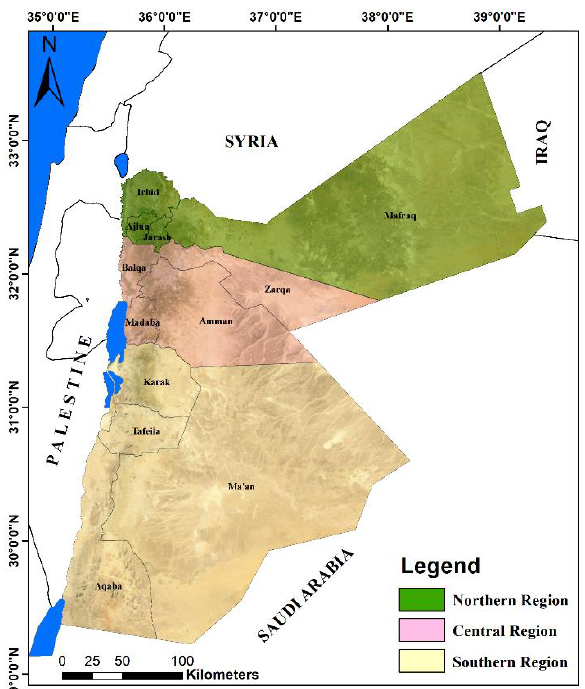
Figure 1. The Hashemite Kingdom of Jordan, Source: GIS World Imagery, GeoEye IKONOS.